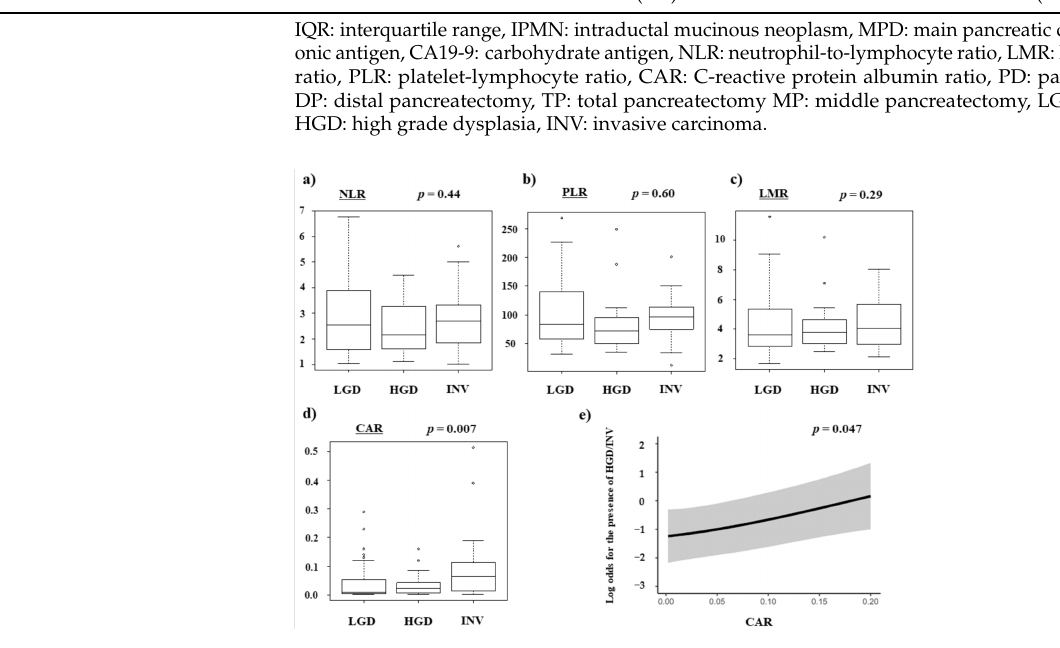
Figure 2. The association between the preoperative inflammation-based scores and 3 subgroups (LDG, HGD and INV). ( a ) NLR. ( b ) PLR. ( c ) LMR. ( d ) CAR. ( e ) The analysis was positively corre- lated ( p = 0.047) and showed that a higher CAR would increase the malignant transformation of IPMN. IPMN: intraductal mucinous neoplasm. NLR: neutrophil-to-lymphocyte ratio, PLR: platelet- lymphocyte ratio, LMR: lymphocyte-to-monocyte ratio, CAR: C-reactive protein albumin ratio, LGD: low grade dysplasia, HGD: high grade dysplasia, INV: invasive